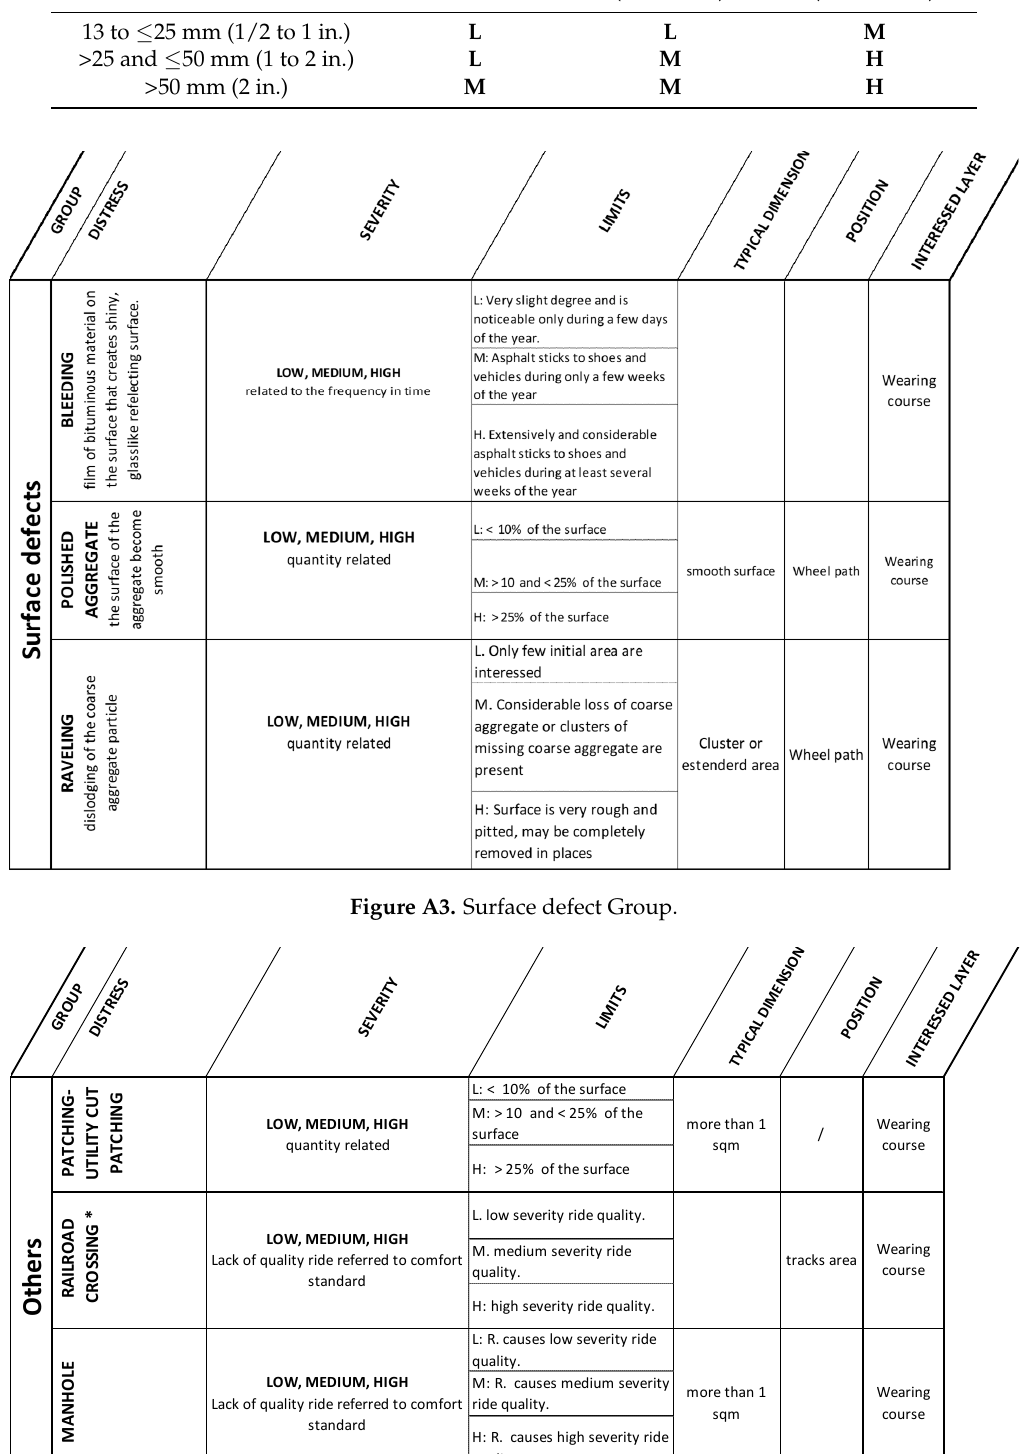
Figure A4. Other Figure A4. Other Distresses.